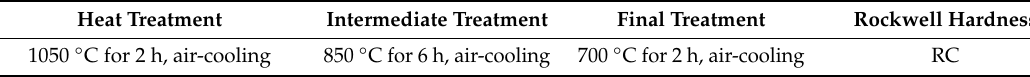
Table 2. Heat treatment conditions of Inconel-800 super alloy.